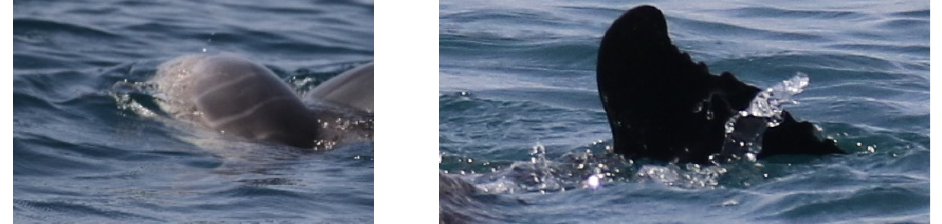
Figure 2. Left picture: the dead new-born with visible fetal folds. Right picture: Edge of the new-born tail visibly marked .